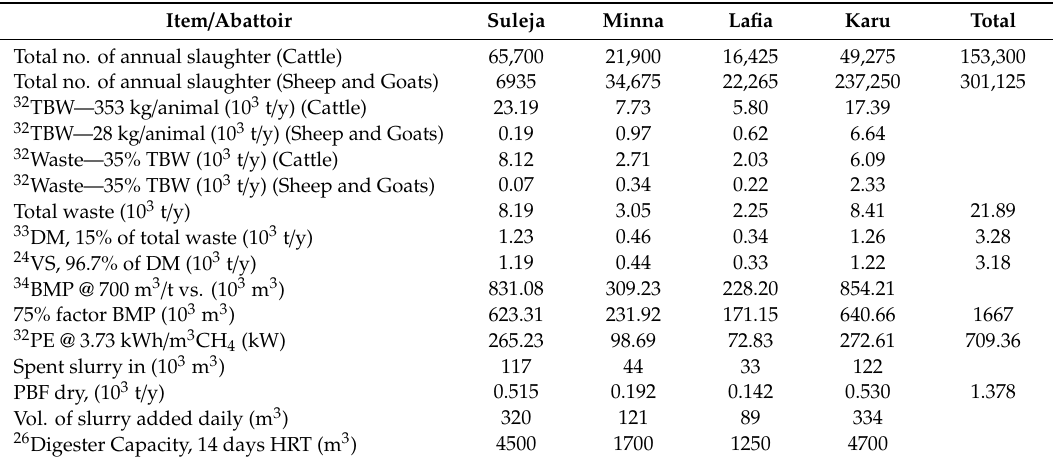
Table 3. Estimates of total wastes generated, biomethane, electricity and mitigated methane emission potentials from the primary